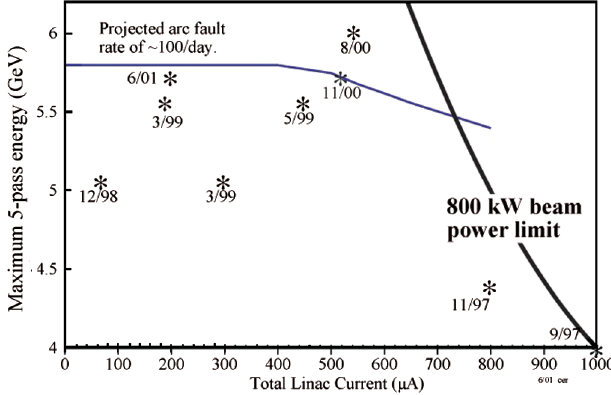
FIG. 17. CEBAF operating highpoints prior to 2002 (from [88]).